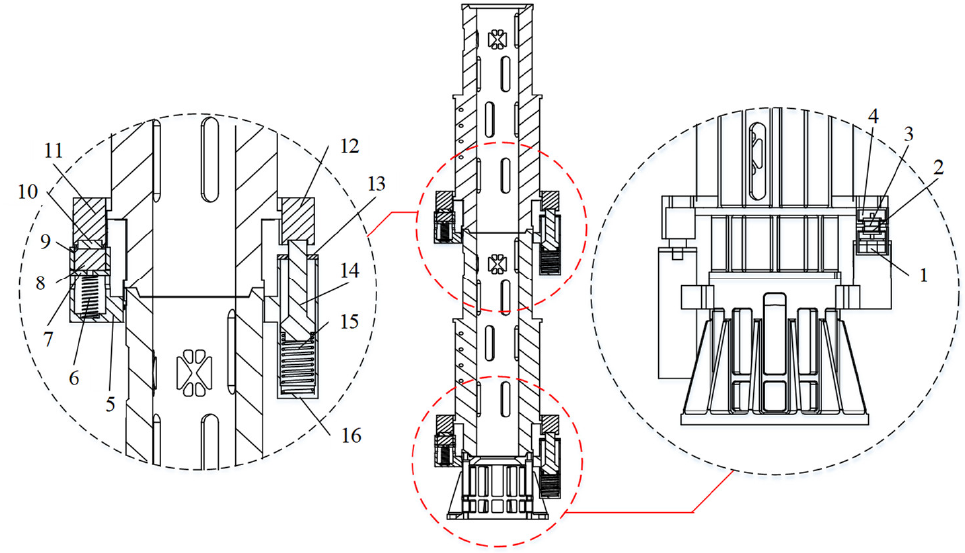
Figure 4. Ejection separation mechanism: 1—Female connector; 2—Female electrical connector; 3—Male electrical connector; 4—Male connector; 5—Electromagnetic connection base; 6—Electromagnetic preload spring; 7—Magnet connection flange; 8—Electromagnet; 9—Thrust cover; 10—Cylindrical iron block; 11—Electromagnetic connection top base; 12—Ejection separation top base; 13—End cap; 14—sliding sleeve guide rod; 15—Separation spring; 16—Ejection Separation base.